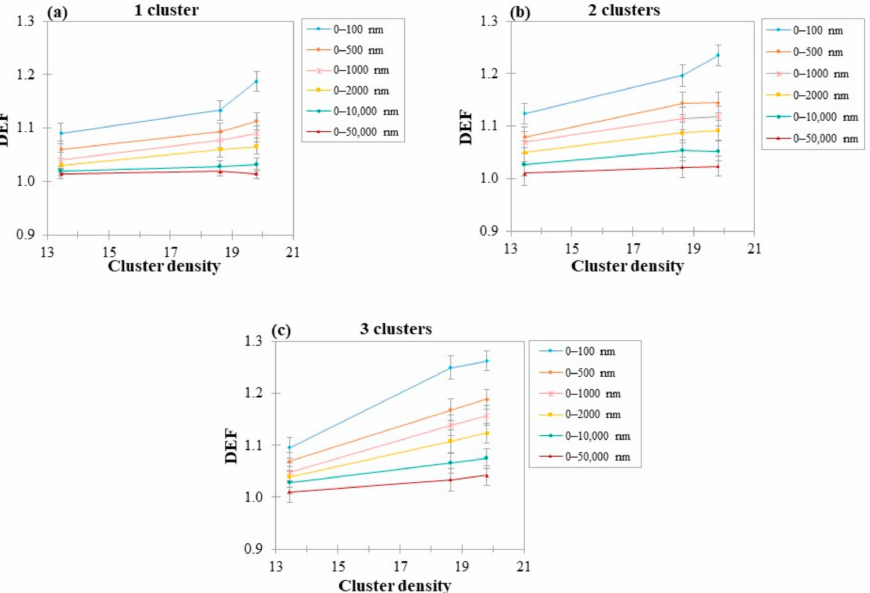
Figure 6. ( a ) DEF as a function of slab density for 1 cluster; ( b ) DEF as a function of slab density for 2 clusters; ( c ) DEF as a function of slab density for 3 clusters. The size of all examined clusters was 100 nm and the photon field used to irradiate AuNPs clusters was 5 × 5 cm 2 (FFF). AuNPs clusters were positioned at a depth of 2 cm inside the mathematical water phantom. Points are connected with lines for illustration